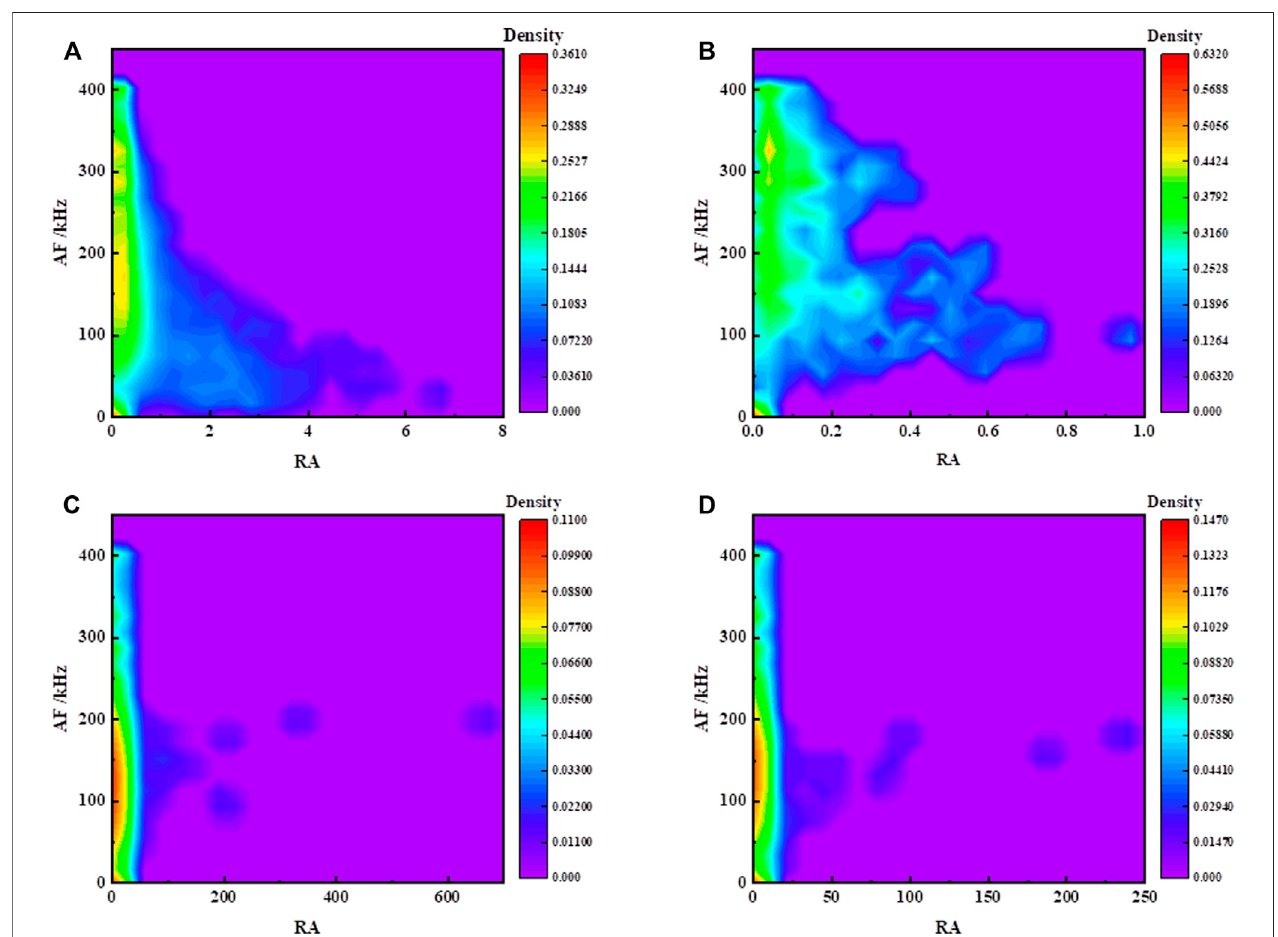
FIGURE 10 | AF-RA data density maps for typical sandstone with different grain sizes under uniaxial compression (A) medium sandstone, (B) coarse sandstone, (C) siltstone, and (D) fi ne sandstone.